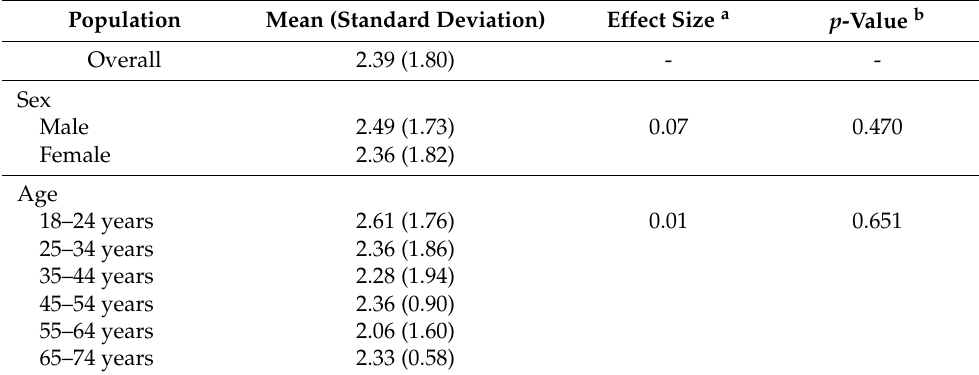
Table 2. Mean number of sexual activities per week in the overall population and by sex and